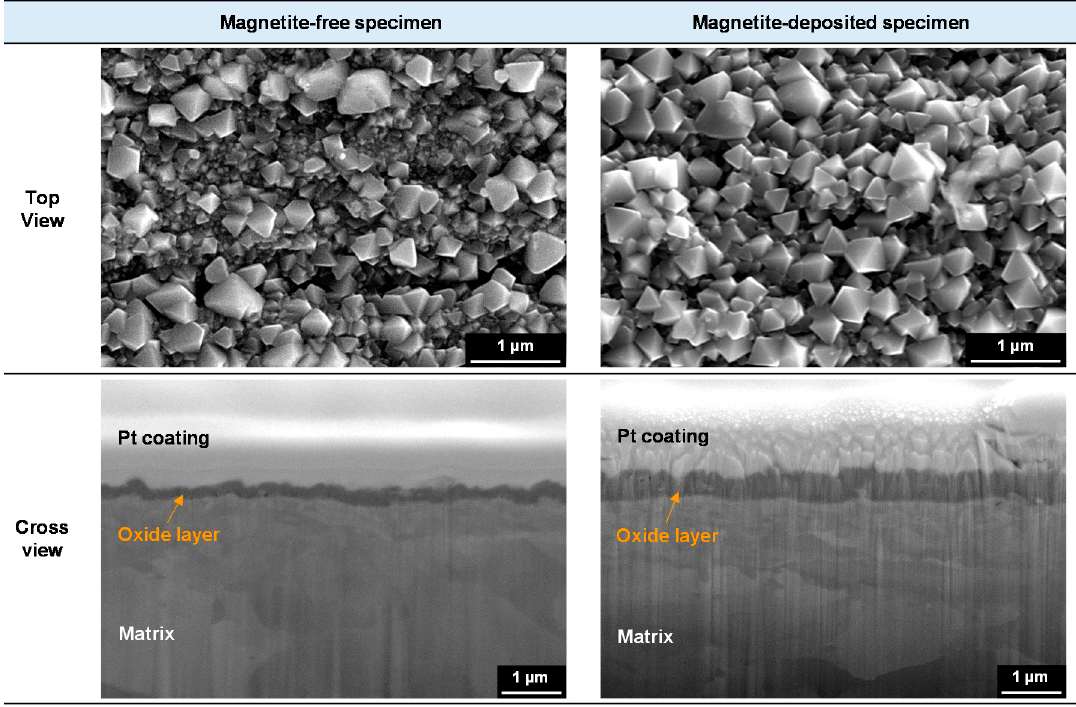
Figure 5. Corrosion morphologies of SA508 exposed to reference solution at 280 °C for 100 h.